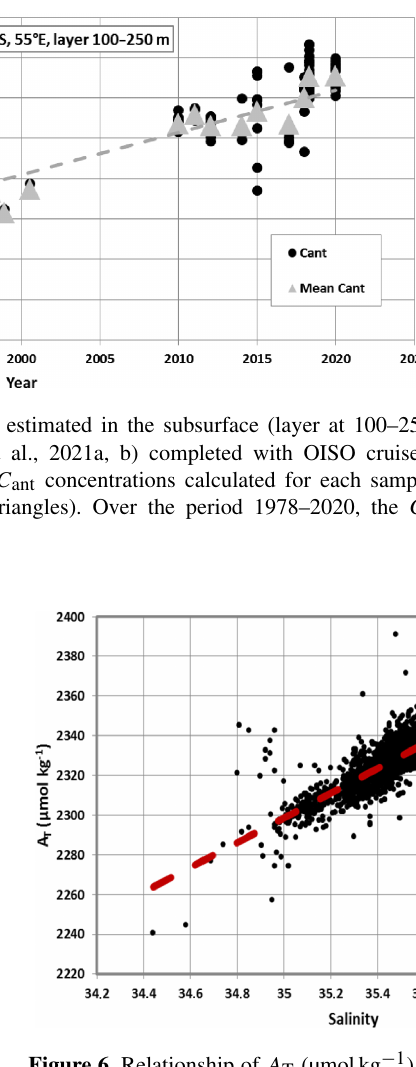
Figure 6. Relationship of A T (µmolkg − 1 ) versus salinity deduced from surface A T data ( n = 3400) obtained during OISO cruises in 1998–2020 in the south-western Indian Ocean. For the sub- tropics we have selected the data in the region 35–20 ◦ S, 50– 70 ◦ E (track of cruises shown in the insert map). The relation- ship (red dashed) is A T = 62 . 1601 · SSS + 123.1 and is used to calculate C T concentrations in this region (Fig. 7). A T data are available at NCEI OCADS (https://www.ncei.noaa.gov/access/ ocean-carbon-data-system/oceans/VOS_Program/OISO.html, last access: 3 March